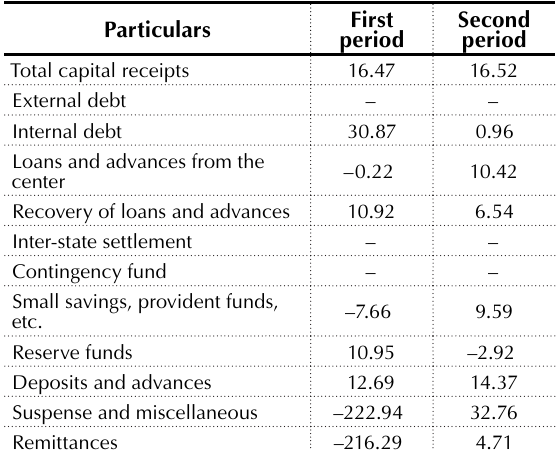
Table 3. Capital receipts of